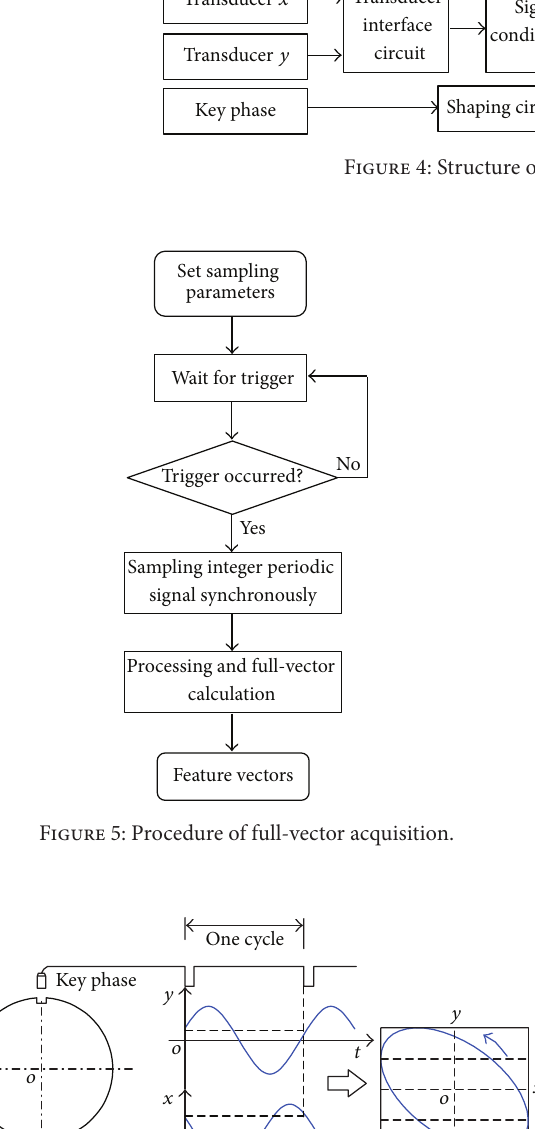
by data fusion, and then the full-vector spectrum is obtained. The obtained full spectrum is good for fault diagnosis